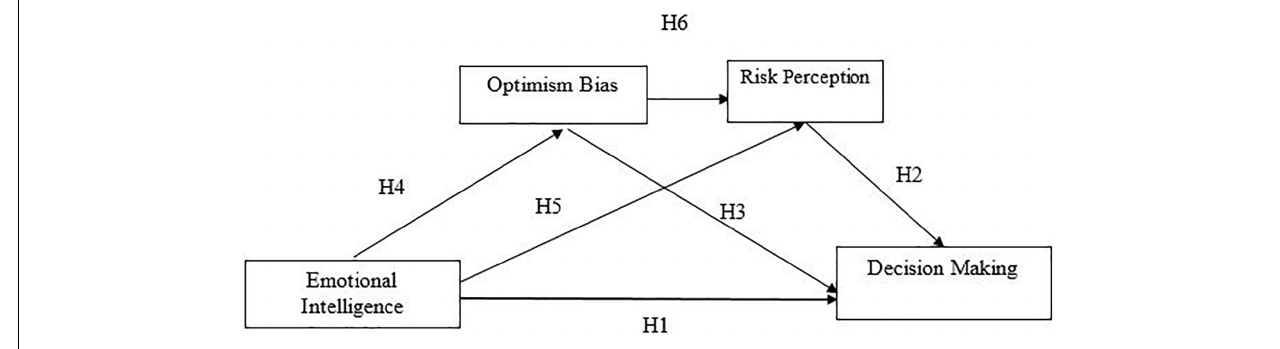
FIGURE 1 | Conceptual